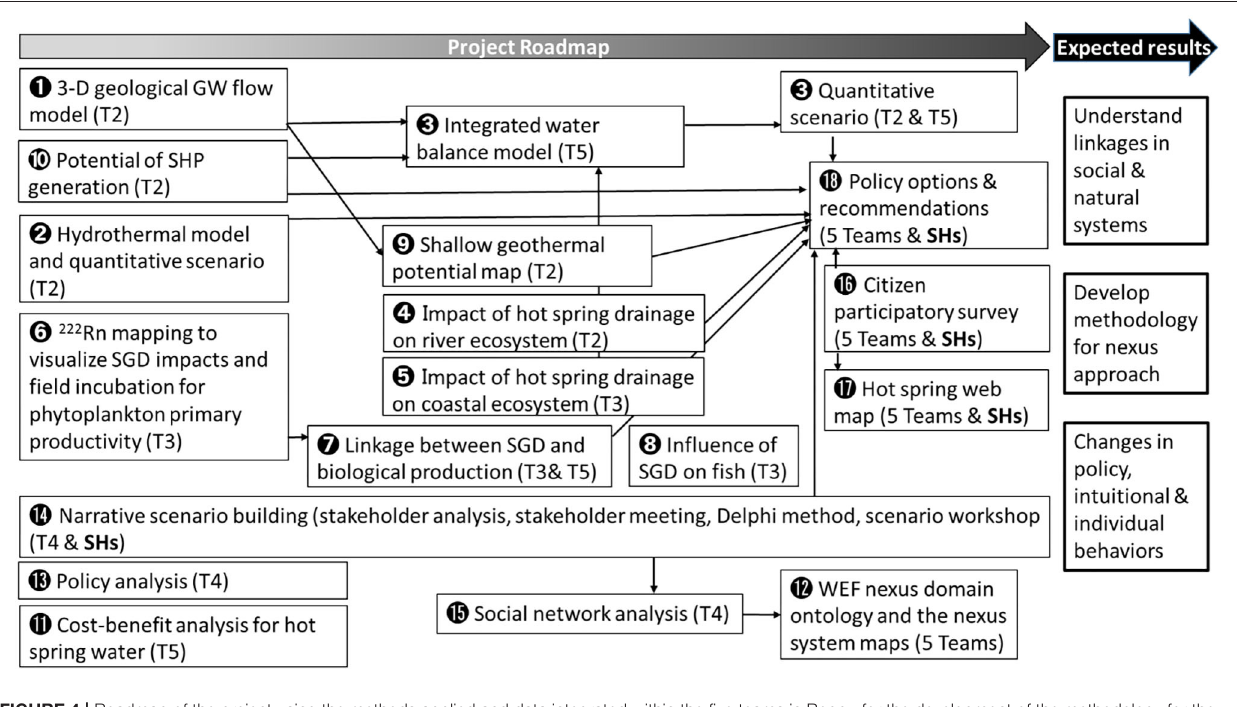
FIGURE 4 | Roadmap of the project using the methods applied and data integrated within the five teams in Beppu for the development of the methodology for the nexus approach. The numbers ( 1 - 18 ) indicate the methods applied and outputs in Beppu in Table 1 , while the arrows indicate the connectivity among each method and output among the five teams. SHs, stakeholders; SGD, submarine groundwater discharge; WEF,